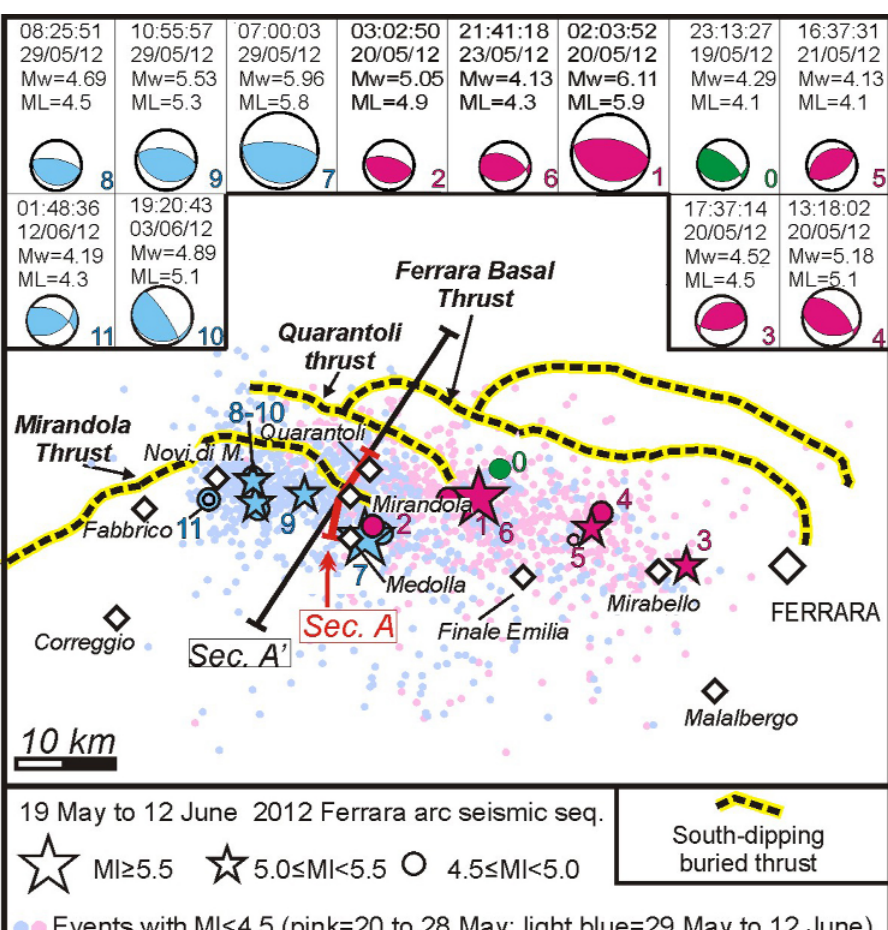
Figure 2. Seismicity and focal mechanisms related to the May 20 and 29, 2012, main events [ISIDe database and Quick RCMT